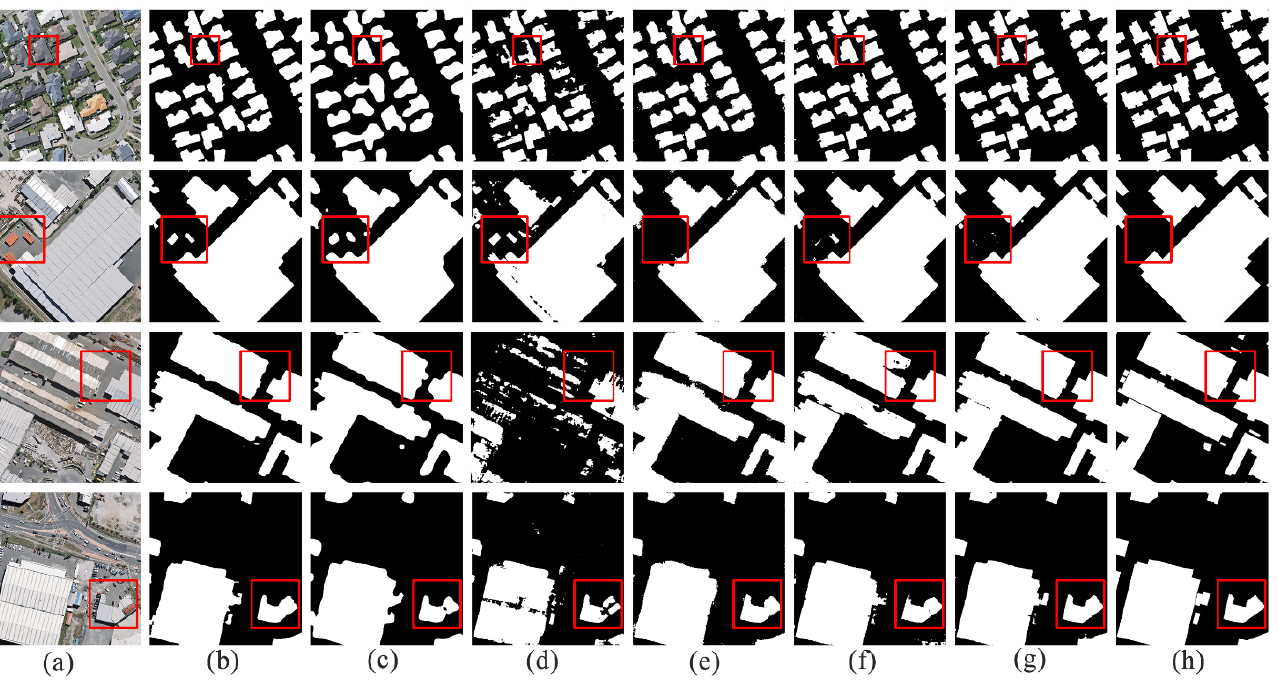
Figure 7. Example of the results with the PSPNet, FCN, DeepLab v3+, SegNet, U-Net, and our proposed method using the WHU building dataset: ( a ) Original image. ( b ) PSPNet. ( c ) FCN. ( d ) DeepLab v3+. ( e ) SegNet. (f ) U-Net. ( g ) Proposed model. ( h ) Ground truth.